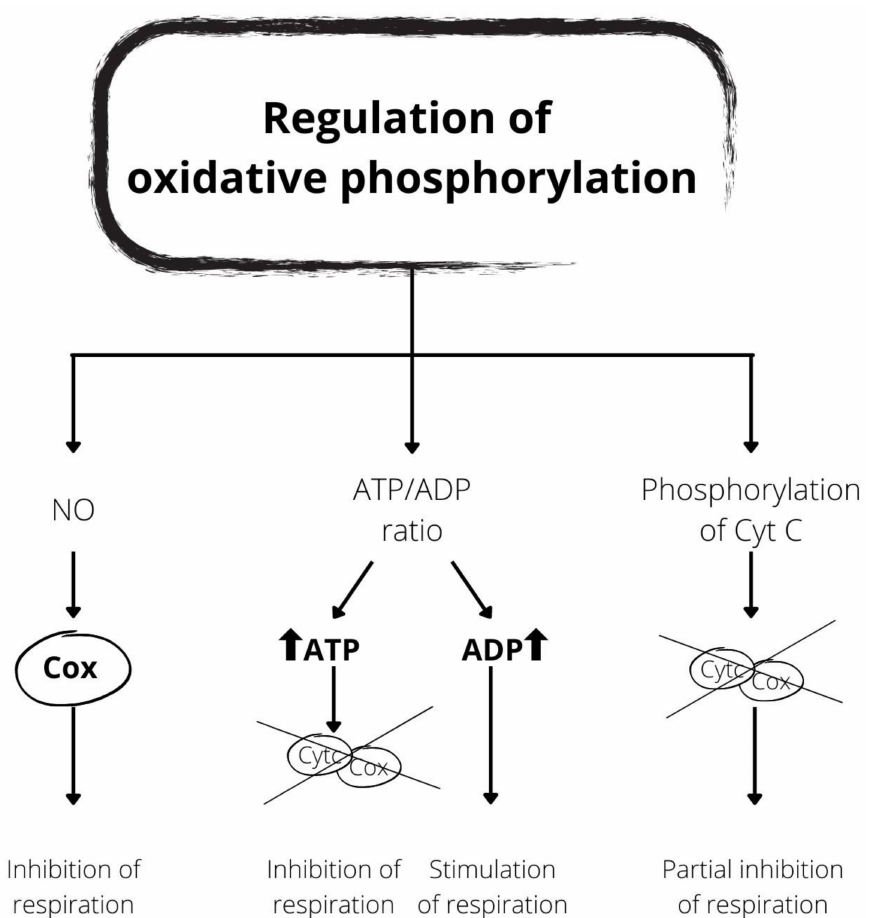
Figure 2. Schematic overview of the main factors involved in OXPHOS regulation. NO, nitric oxide; Cox, cytochrome oxidase; Cytc, cytochrome C. ATP: Adenosine triphosphate. ADP: Adenosine